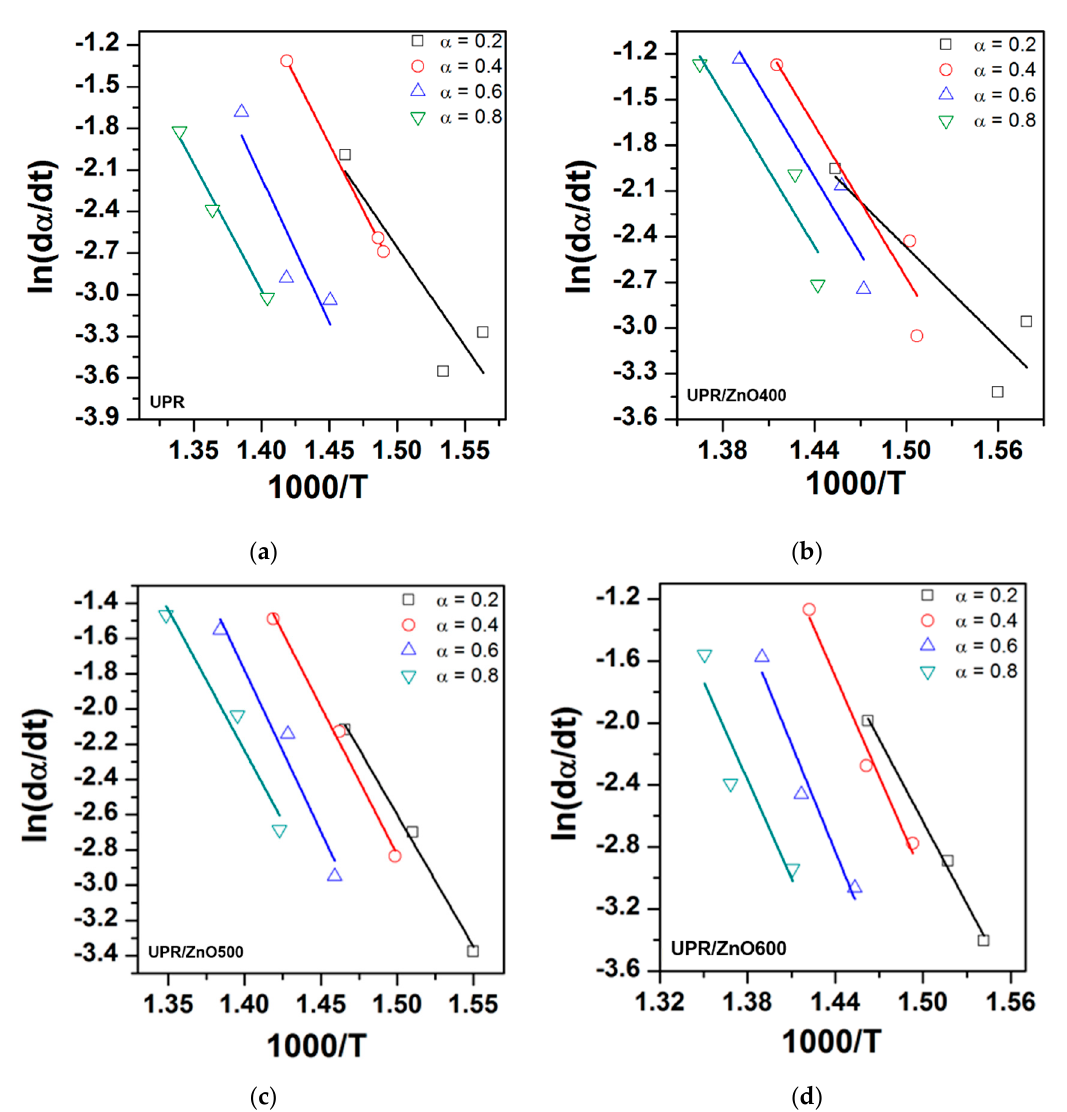
Figure 7. Isoconversion plot of the Friedman method ( a ) UPR, ( b ) UPR/ZnO400, ( c ) UPR/ZnO500 and ( d ) UPR/ZnO600.